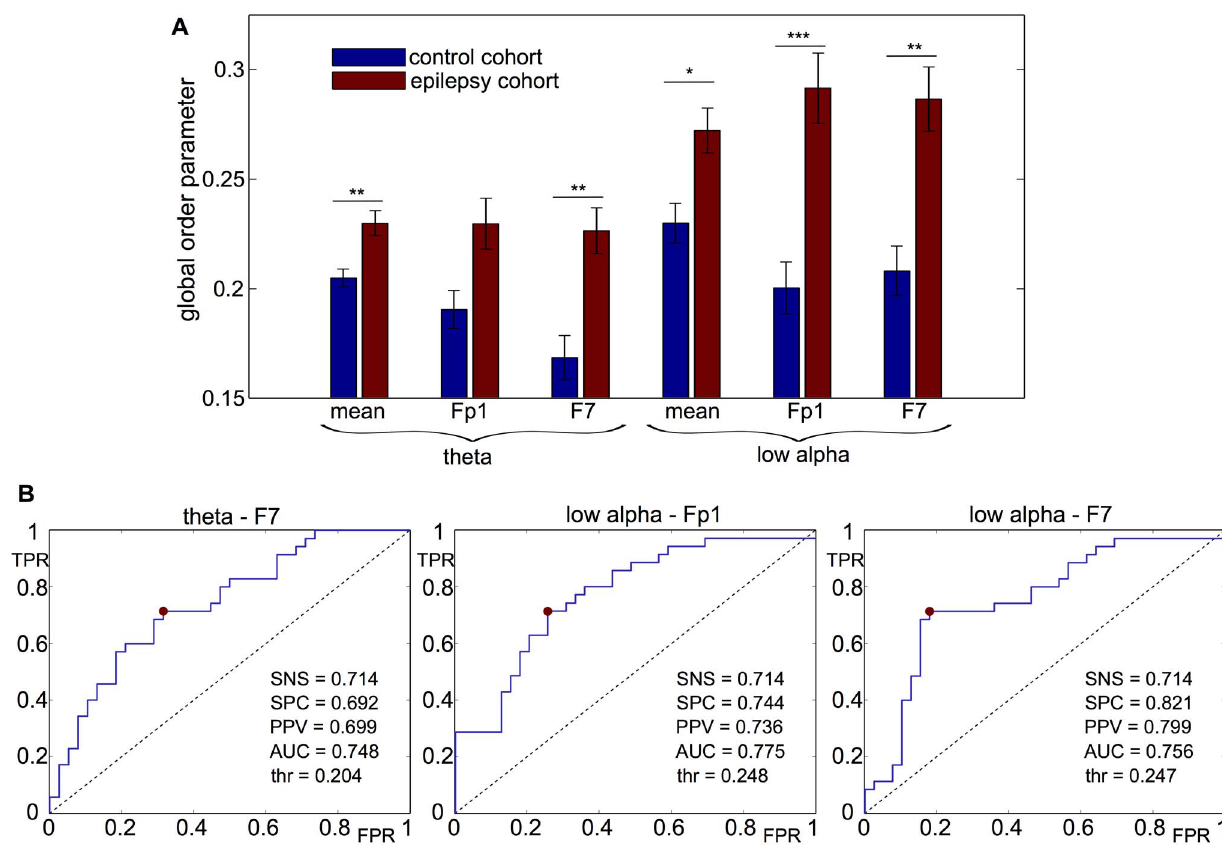
Figure 9. The global (average) order parameter of the network when one node is self-synchronized. A : We show here the result for self- synchronization in Fp1 and F7, and also the average over all electrodes, in the theta band and low alpha band. Other electrodes are omitted as they do not yield significant results when p-values are Bonferroni-corrected by a factor of 19 (the number of electrodes). This finding confirms the result of previous studies (see text) that identified frontal and pre-frontal areas as seizure onset zones. Levels of significance: (cid:2) u p v 0 : 05 ; (cid:2) (cid:2) u p v 0 : 01 ; (cid:2) (cid:2) (cid:2) u p v 0 : 001 . Parameters: K ~ 0 : 8 for all nodes except self-synchronized node with K ~ 2 ; C ~ 0 : 2 . Error bars indicate the standard error of the mean. B : Receiver operating characteristic for the detection of the epilepsy cohort by using the global (average) order parameter as discriminating factor in F7 in the theta-band, and Fp1 and F7 in the low-alpha band. Again, the red dot indicates the point with best discrimination. Abbreviations as per Figure 8.